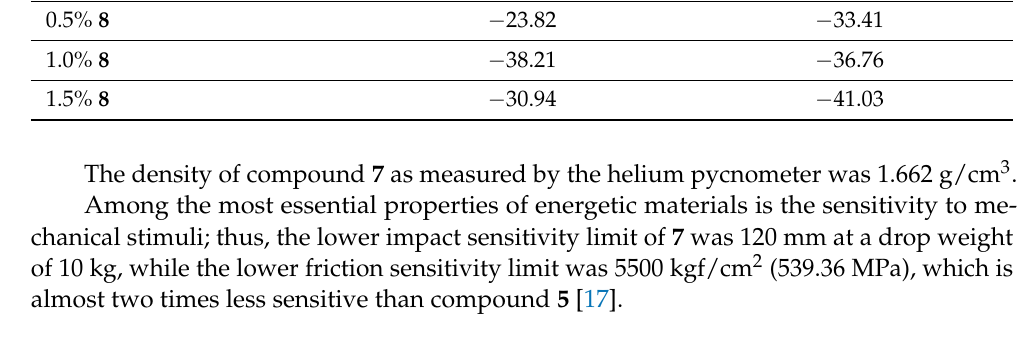
Table 3. Burning rate as a function of concentration of modifier 8 in the formulation.